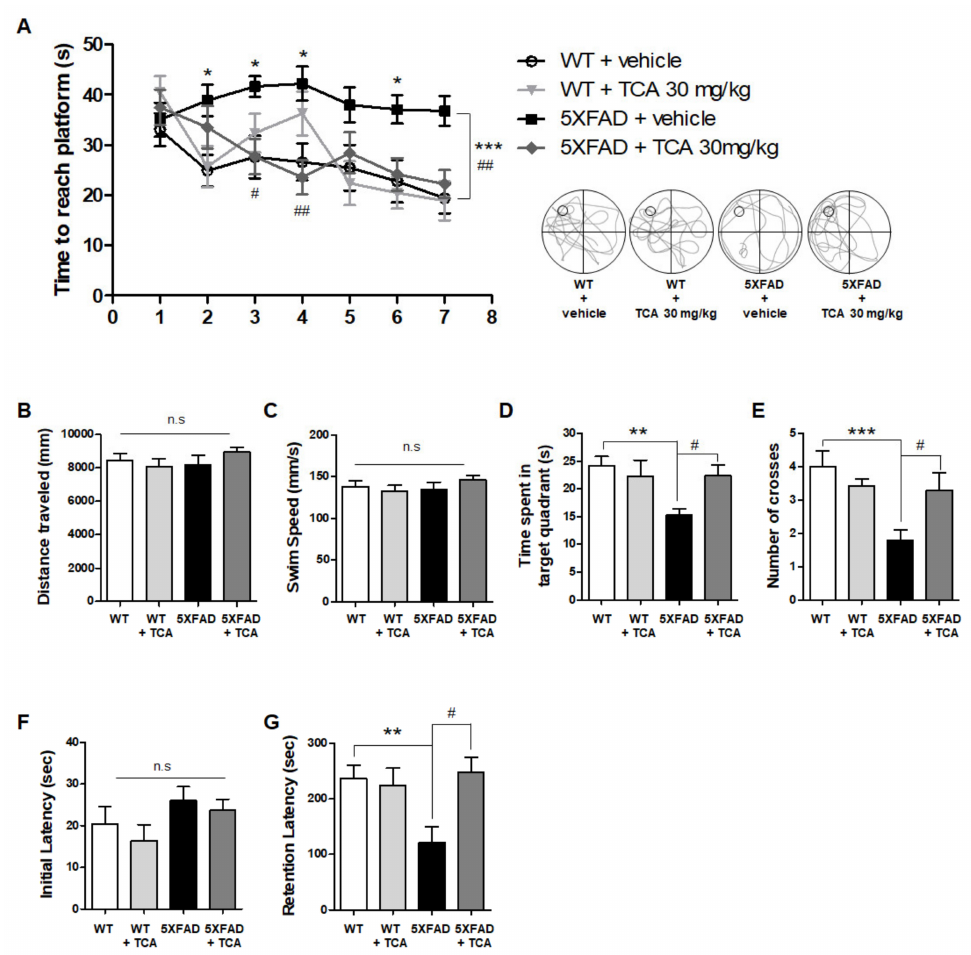
Figure 2. TCA improves cognitive performance in 5XFAD mice. ( A ) Spatial learning and memory were analyzed by estimating the time to reach a hidden platform for seven consecutive days. To analyze acquired memory, distance traveled ( B ), swim speed ( C ), time spent in the target quadrant ( D ), andnumberoftargetcrosses( E )wereidentifiedbytheprobetest(removaloftheplatform). ( F , G )Implicit memory was analyzed by measuring the time to enter the dark chamber. There was no di ff erence in the initial latency ( F ), whereas there was a di ff erence after the electric shock ( G ). All results are expressed